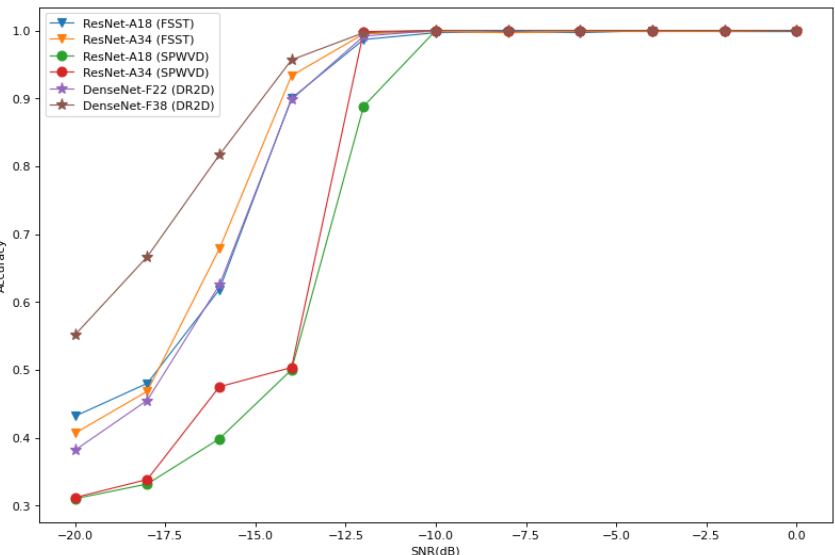
Figure 16. The average recognition accuracy curves produced with different numbers of layers for the DenseNet-F models and ResNet-A models proposed in reference [15] in environments with different